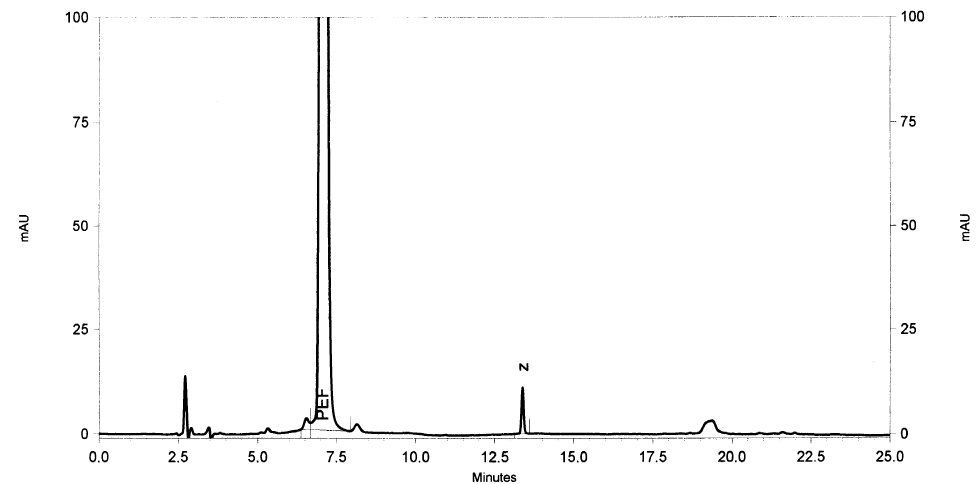
Figure 10. Chromatogram of the PEF oxidized by H 2 O 2 after incubation for 56 days at room temperature.